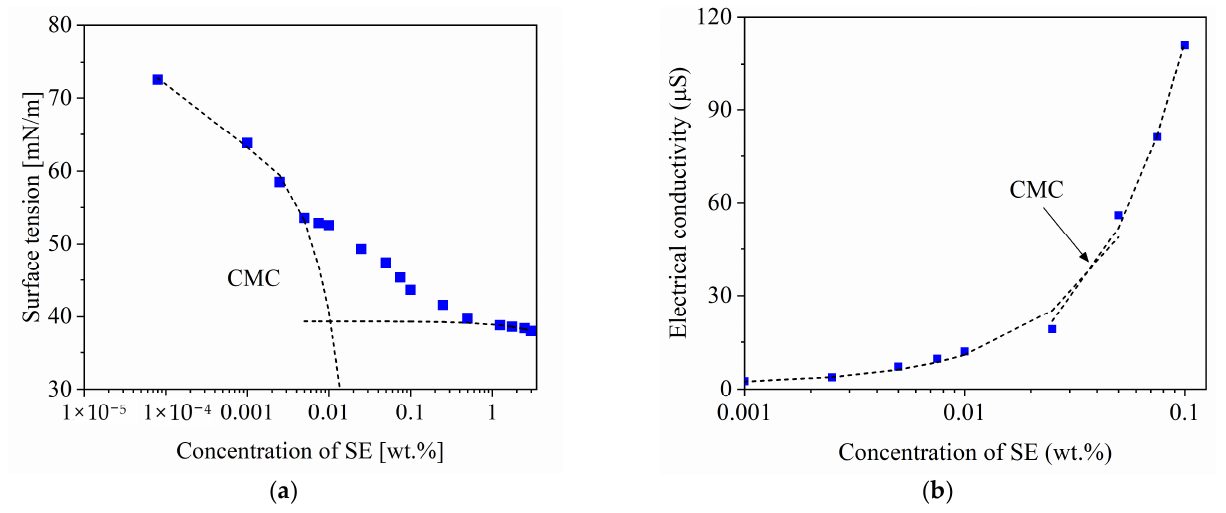
Figure 2. ( a ) Surface tension and ( b ) electrical conductivity at different content of SE at 25 °C.